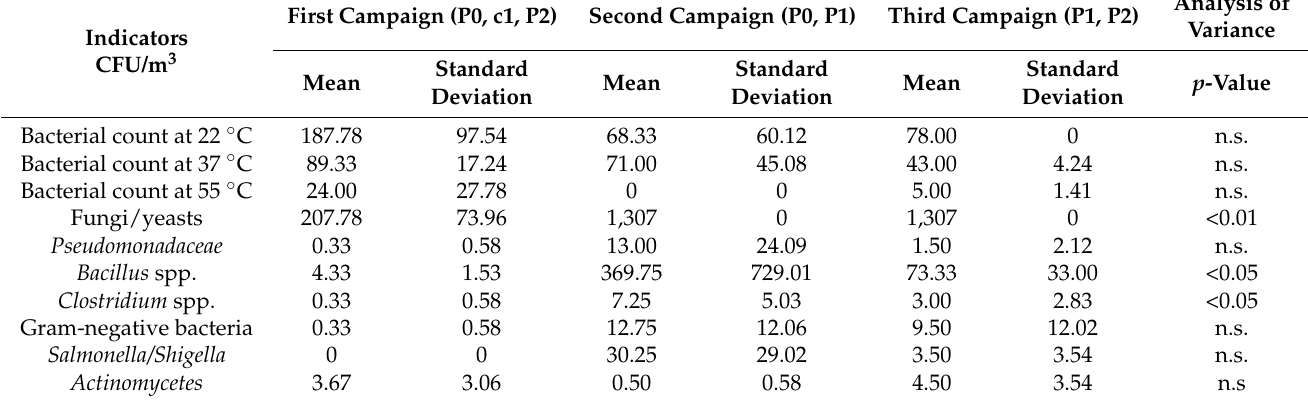
Table 3. Microbial concentrations measured in all three sampling campaigns. CFU, colony-forming